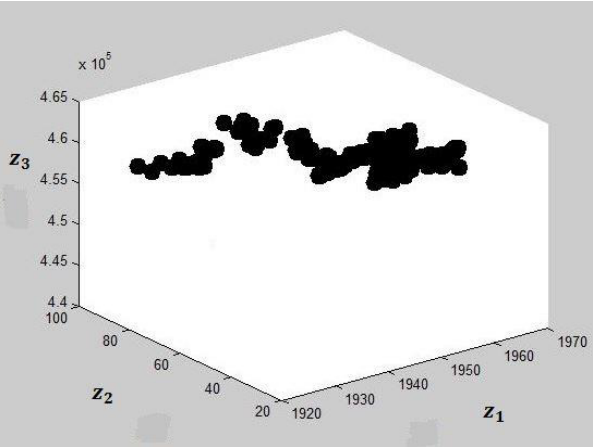
Fig. 7. The Pareto frontier obtained by using the COA/ε -Constraint method for ten suppliers.